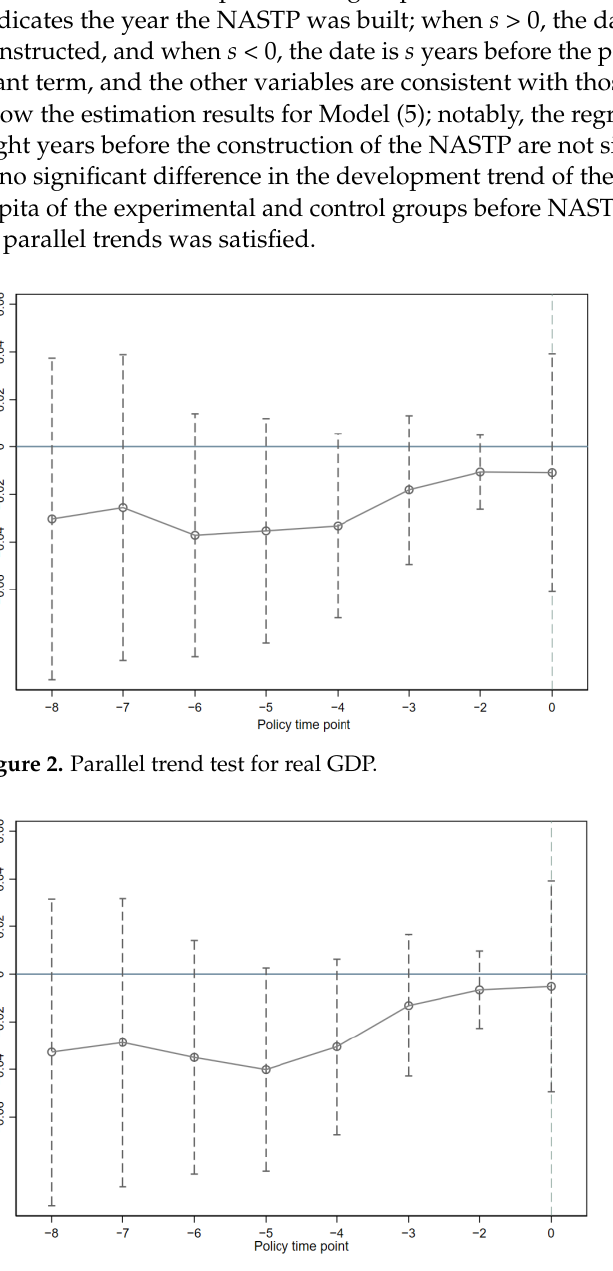
Figure 3. Parallel trend test for per capita real GDP.